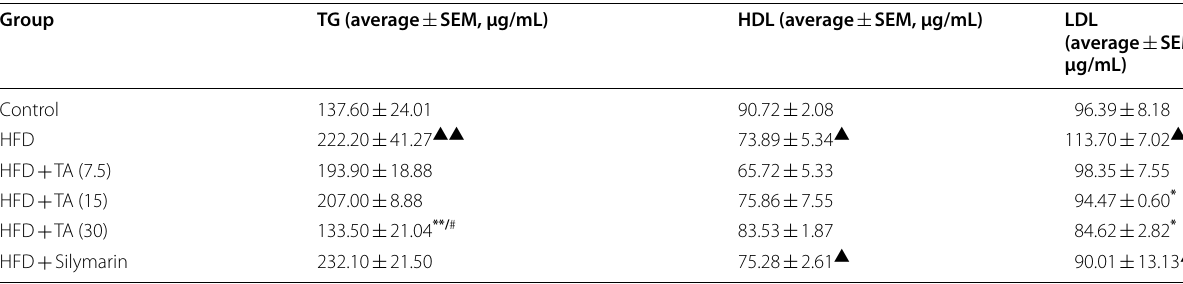
TG, HDL, and LDL were measured in μg/mL. Control: mice were fed a normal diet and treated with 0.5%CMC-Na (solvent) via gavage; HFD: mice were fed HFD; HFD TA (7.5), HFD TA (15), and HFD TA (30) mice were fed HFD and treated with TA (7.5, 15, and 30 mg/kg, respectively) via gavage; HFD + + + fed HFD and treated with silymarin via gavage. ▲ / ▲▲ P < 0.05/0.01 vs. Control; */** P < 0.05/0.01 vs. HFD group. # P < 0.05 vs. HFD Table 3 Effects of TA treatment on blood aminotransferase levels in HFD‑fed mice